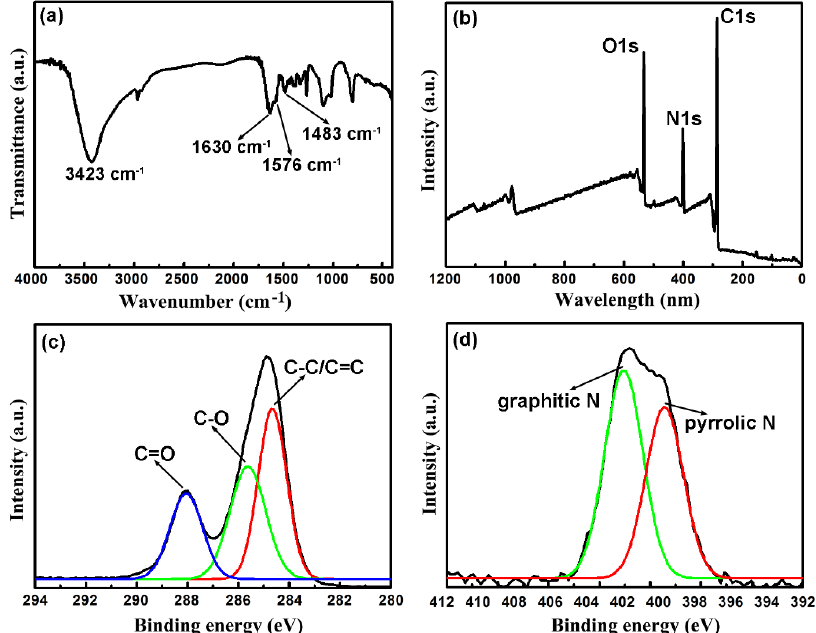
Figure 3. ( a ) FTIR spectrum of the CNDs. ( b ) XPS survey spectrum of the CNDs. High-resolution scans of ( c ) C 1s and ( d ) N 1s spectra of the CNDs.